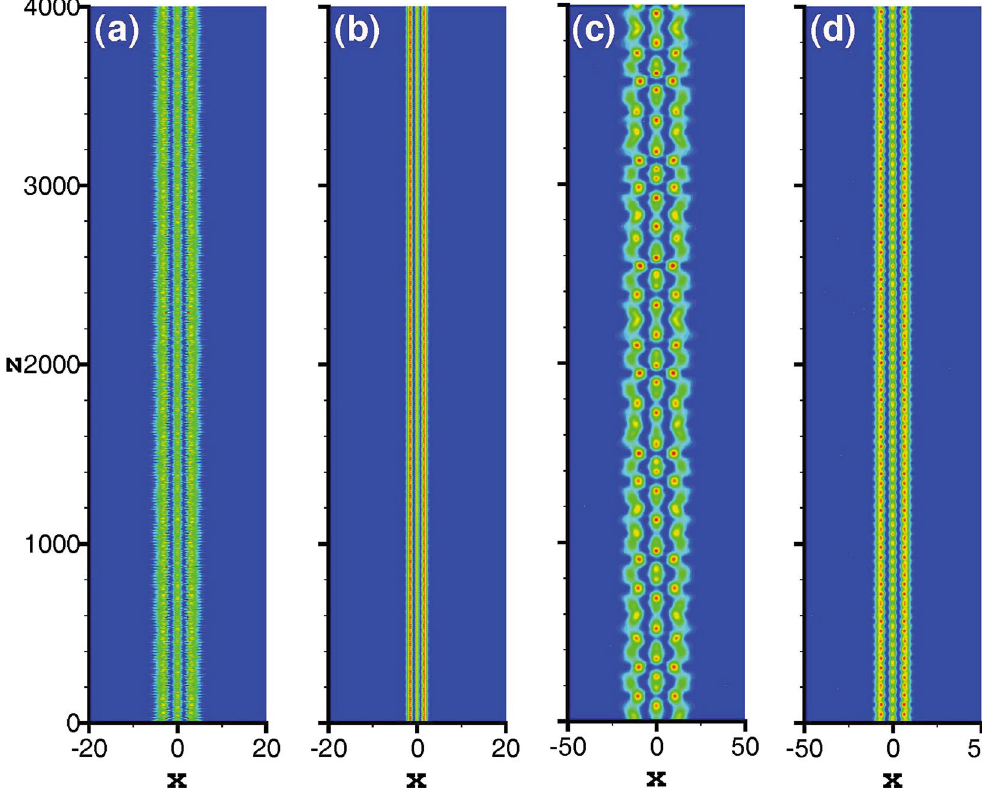
Figure 9. Propagation of tripole-mode solitons in the presence of 1% white input noise. The profiles of Fig. 3(a,d) are employed as the input shapes of solitons in ( a , b ), and the profiles of Fig. 8(a,c) are employed as the input shapes of solitons in ( c , d